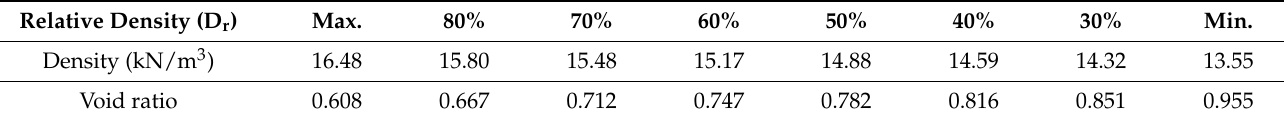
Table 3. Measurement of relative density for sandy soil in the laboratory model test.